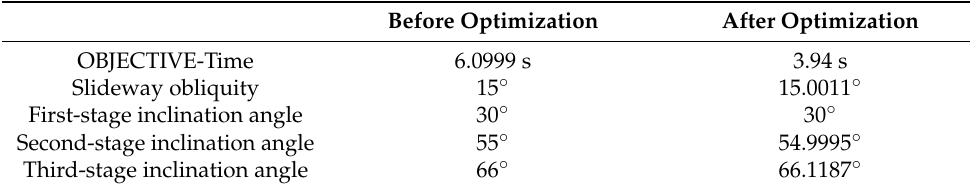
Figure 22. Variation curve of the optimization target in the iterative process. The x-axis represents the number of iterations, and the y-axis indicates the time taken by the spherical material to fall from the top of the slideway to stably rest at the center of the identification table, which represents, the objective function value. Table 10. Waste sorting time and variables before and after optimization.